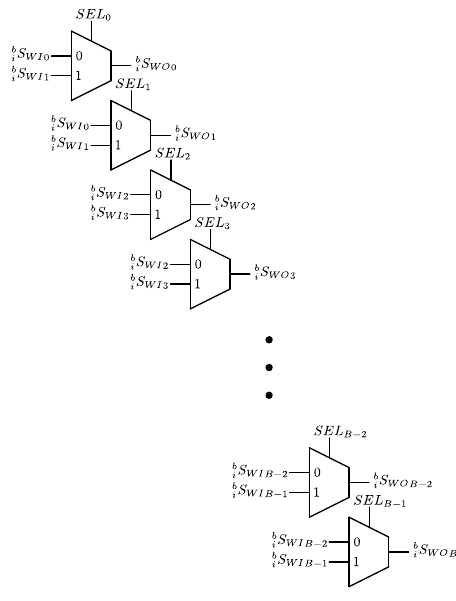
Figure 8. Hardware implementation of the